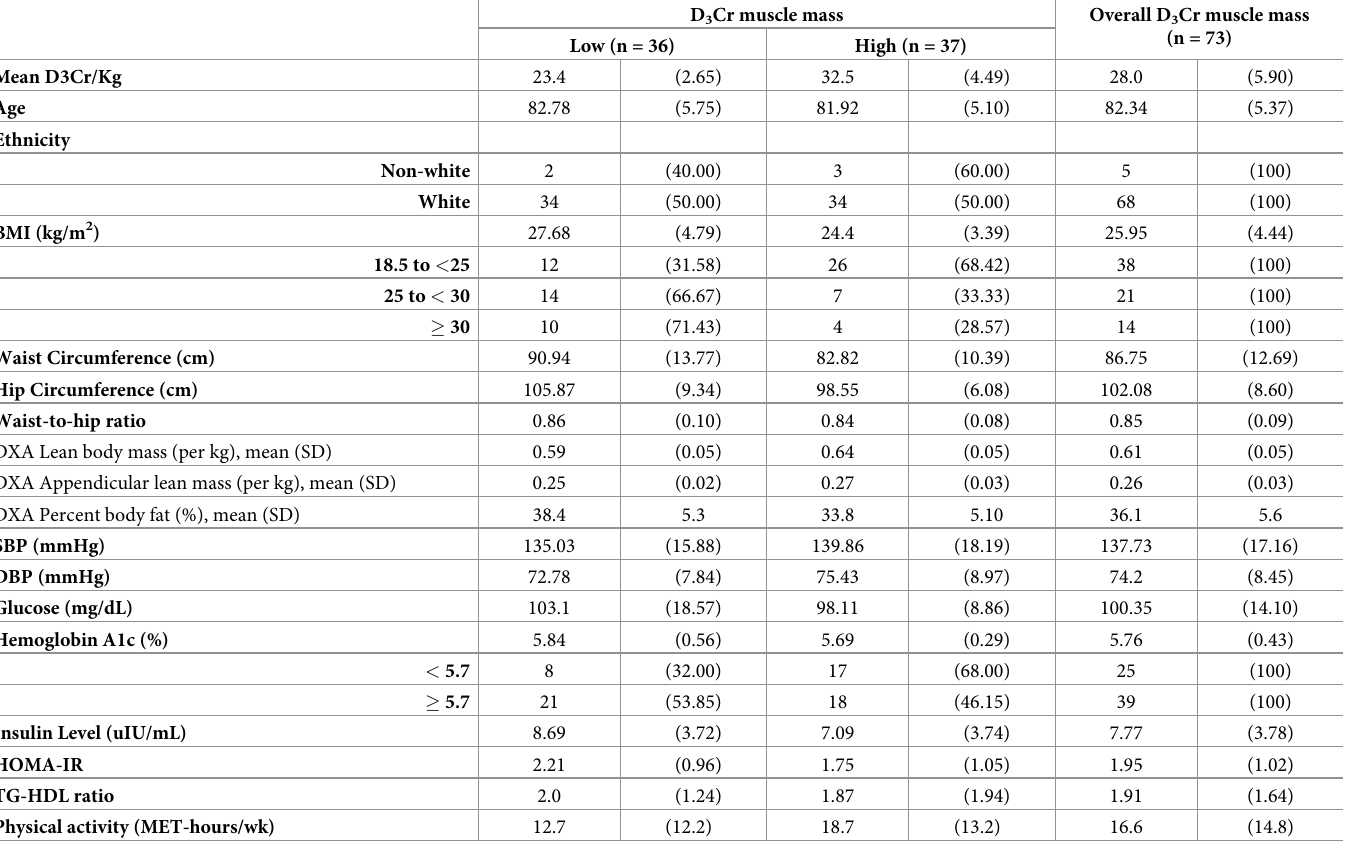
Table 1. Descriptive characteristics of the study sample and indices of insulin-glucose homeostasis in the total sample and by D 3 Cr muscle mass categorized by median split mean(sd) or